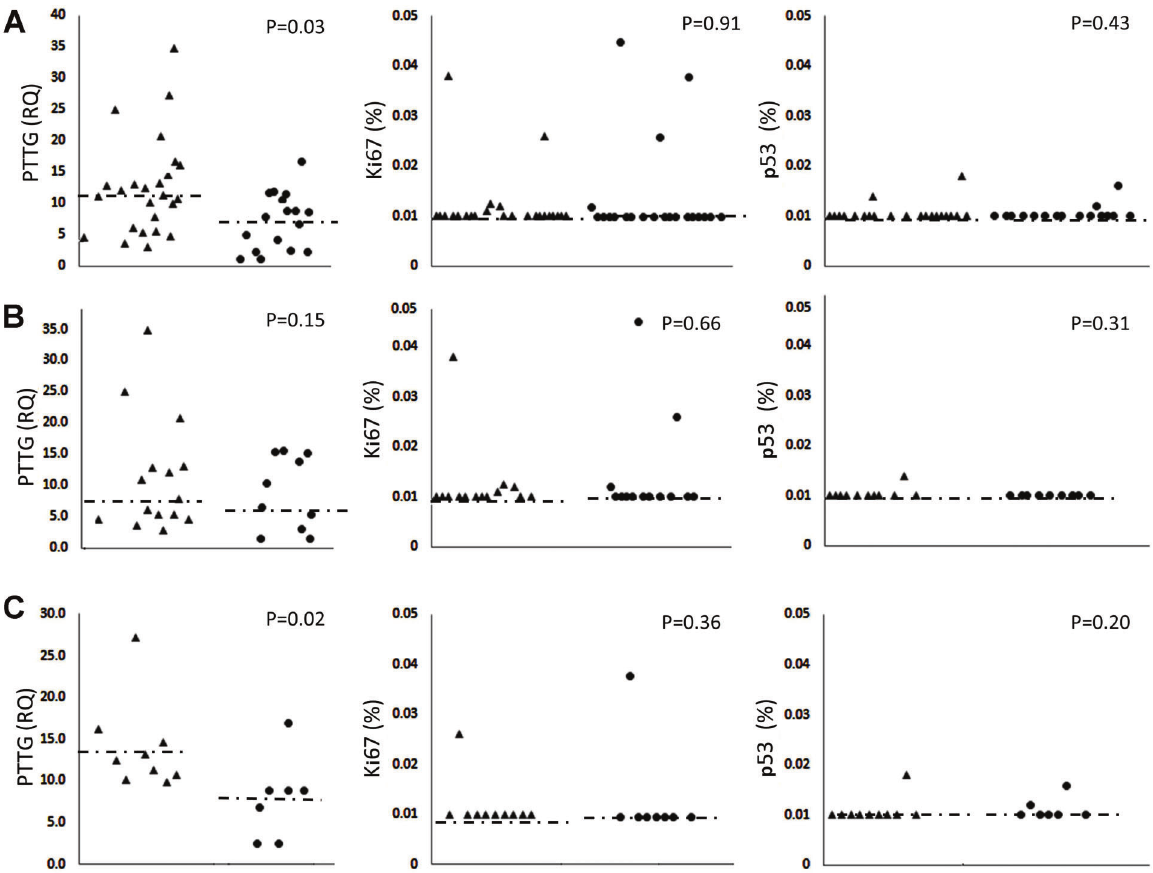
Figure 1. Expression of histological and molecular markers of proliferation/invasion in invasive and non-invasive pituitary adenomas. Graphs represent distributional plot of qPCR results for pituitary tumor transforming gene ( PTTG ) and immunohistochemical analysis (Ki67 and p53), with the scoring for the respective marker depicted in the y-axis. A , Somatotropinomas and non-functioning pituitary adenomas (NFPA). B , Somatotropinomas. C , NFPA. Dashed lines: medians; triangles: invasive cases; circles: non-invasive cases. RQ: relative quanti fi cation. Mann-Whitney U test was used for statistical